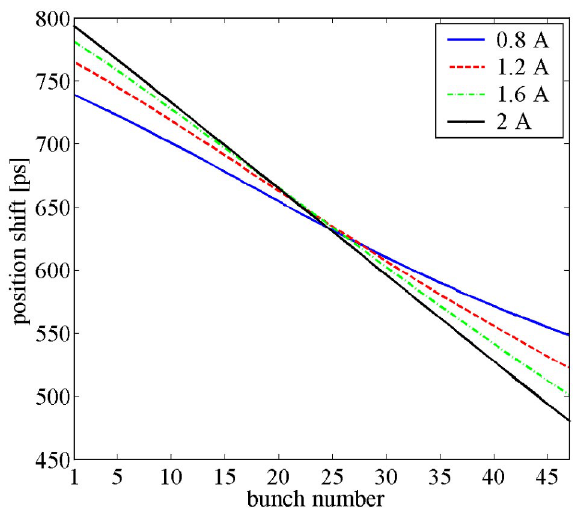
FIG. 7. (Color) Synchronous phase spread for various currents.